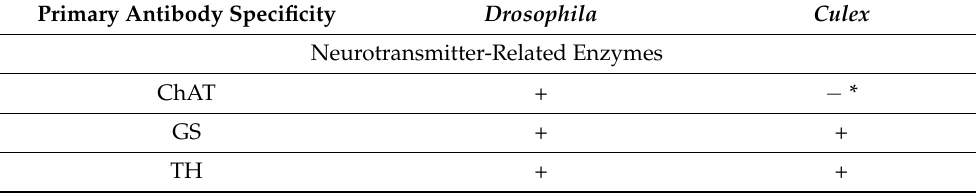
Table 2. Cont. Primary Antibody Specificity Drosophila